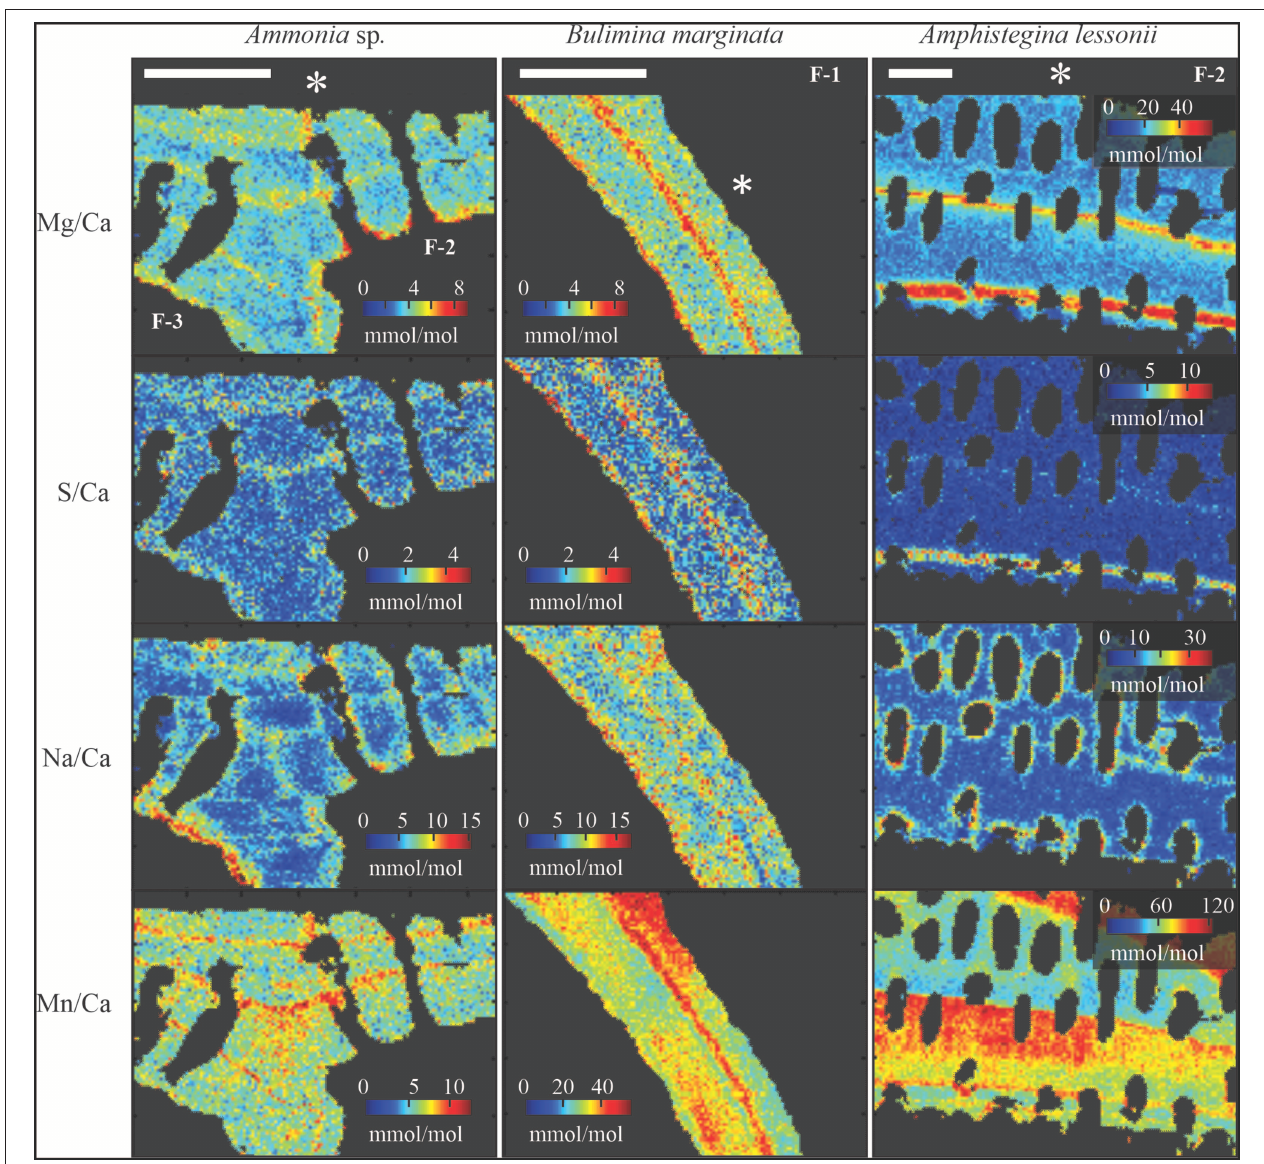
FIGURE 5 | EPMA element distribution maps (Mg/Ca, S/Ca, Na/Ca, and Mn/Ca) for three species of benthic foraminifera, Ammonia sp. T6 (left panels), Bulimina marginata (center panels), and Amphistegina lessonii (right panels), from treatment Aq600 (Mn/CaS EAWATER = 50.9 ± 0.8 mmol/mol). The top maps show information on chamber number (scale bar of 10 µ m), and the asterisk indicates the outer side of the test. Maps are semiquantitative (see Electron Probe Microanalysis ). EPMA, electron probe microanalysis.